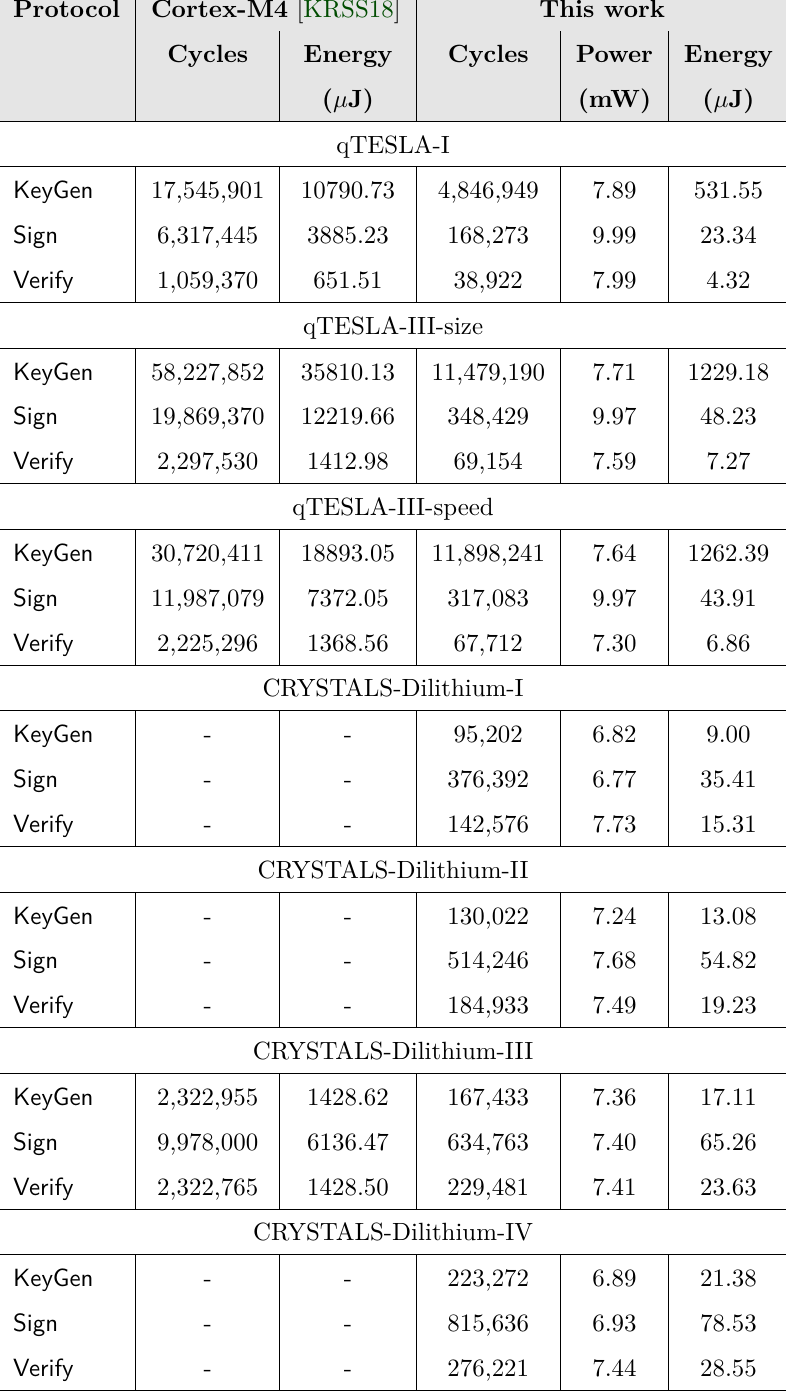
Table 9: Measured energy and performance of digital signature